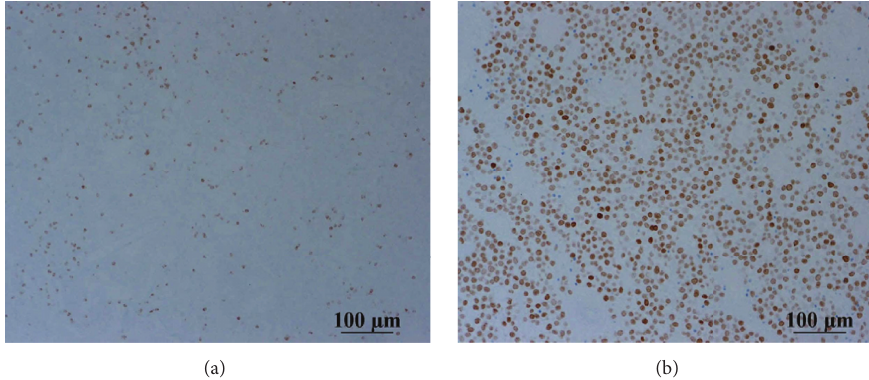
Figure 4: Left testis section. Immunostains for (a) CD79a (negative) and (b) SALL4